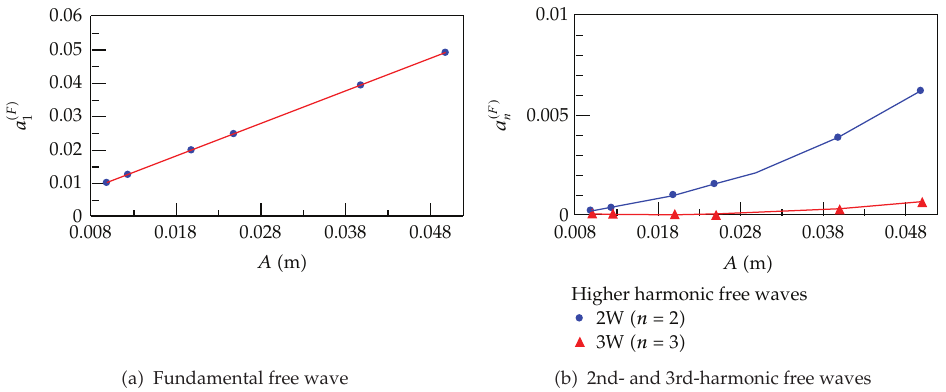
Figure 8: First-, second-, and third-harmonic free wave amplitudes at the lee side of submerged bar for h (cid:9) 0 .